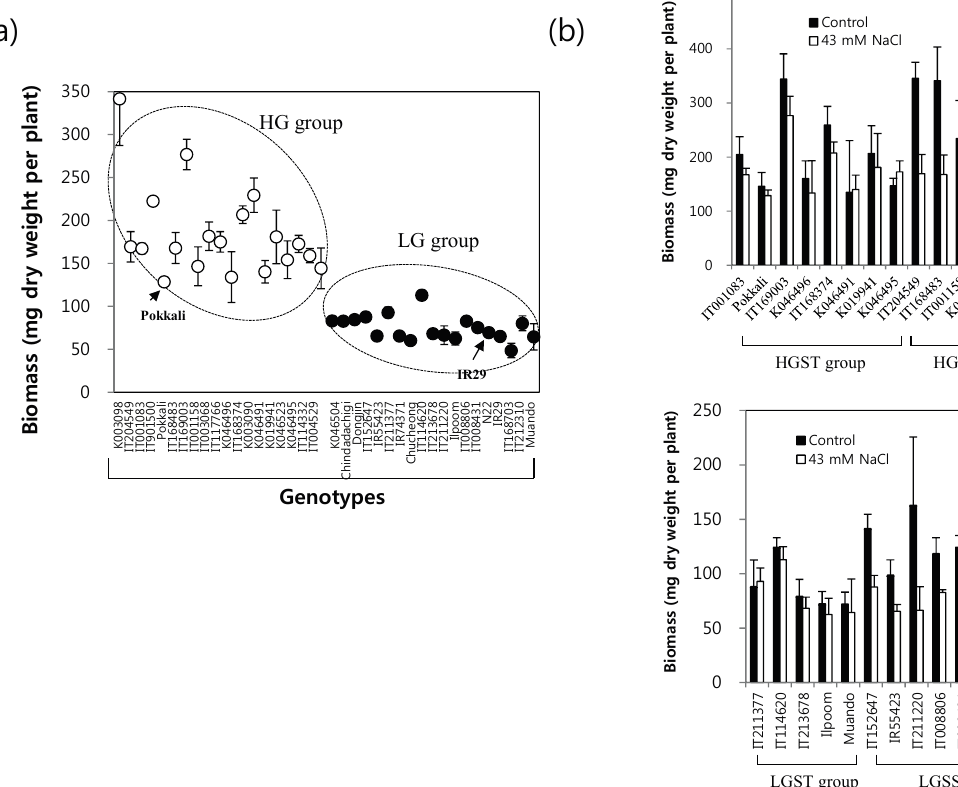
Figure 1. ( a ) Rice germplasms differing in the ability of biomass accumulation in the presence of moderate salinity. Imposition of 43 mM NaCl supplemented to half strength Yoshida’s nutrient solution started on rice seedlings of the three or four foliar leaf stage, which is known as a sensitive growth stage to salinity and ended at 14 days after starting the salinity imposition. Biomass was determined after the end of salinity treatment. Reference rice genotypes were used for cv. “Pokkali” (129 ± 5.2 mg) as a relatively tolerant genotype and for cv. “IR 29” (65 ± 5.5 mg) as a relatively sensitive one. Each mark represents the mean of nine plants. HG, high growth group; LG, low growth group; ( b ) Changes in the biomass accumulation of rice genotypes in response to 43 mM NaCl. Genotypes showing less than a 20% inhibition of biomass accumulation by salt stress were grouped as the salt-tolerant (ST) and genotypes with more than 30% inhibition as the salt-sensitive (SS) group. Bars indicate